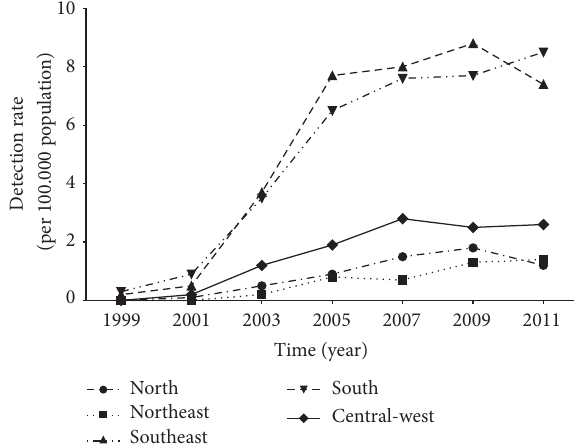
Figure 3: Hepatitis C detection rates in Brazil according to the Ministry of Health